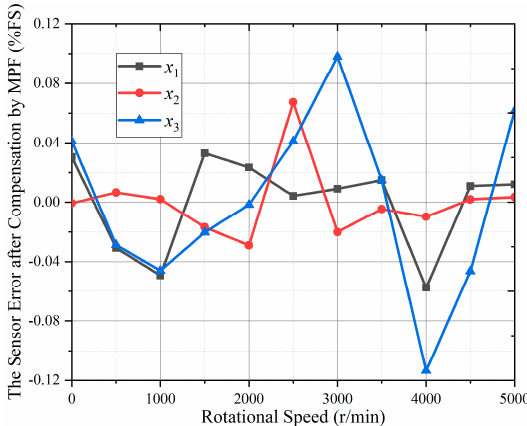
Figure 10. The torque calculation relative errors compensated by multivariate polynomial fitting (MPF).